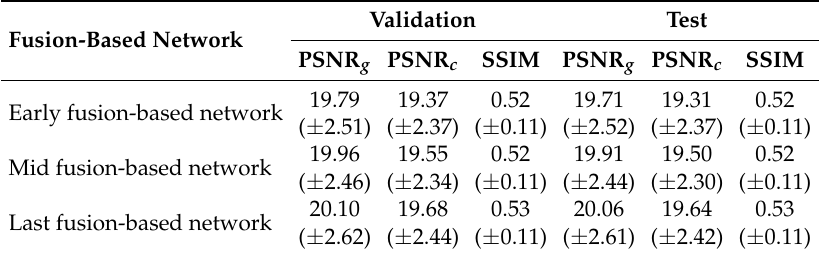
Table 3. Image quality performance results of the proposed fusion-based color image generation in